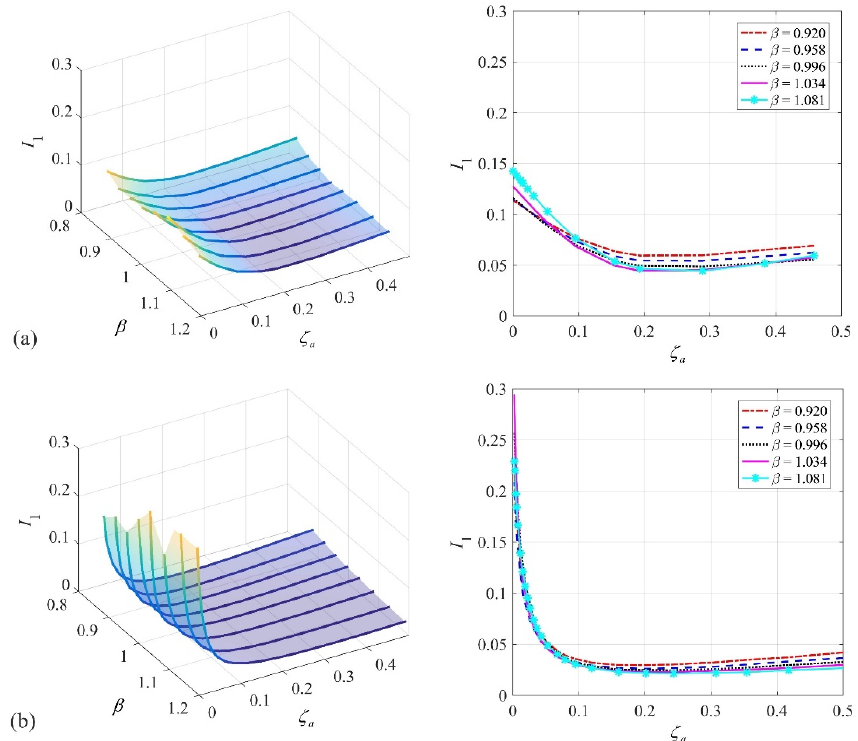
Figure 17. 3D and 2D plots of I 1 with µ = 0.154: ( a ) experimental result; ( b ) simulation result.